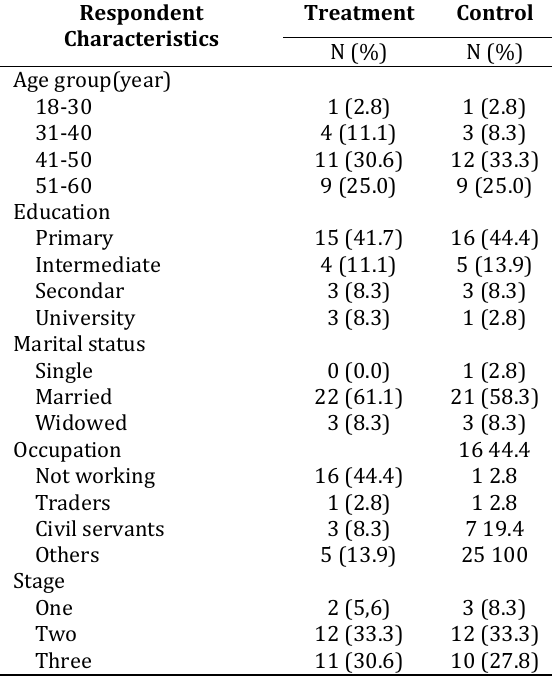
Table 1. Characteristics of Breast Cancer